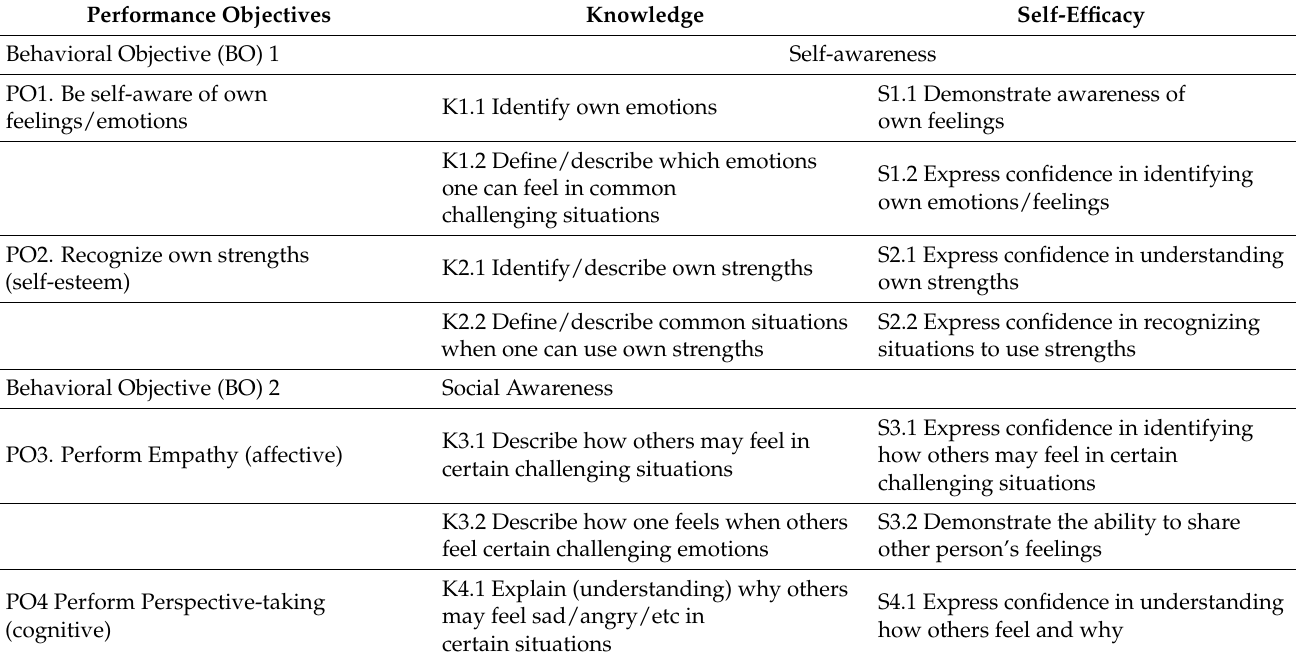
Table 2. Matrix of Change Objectives: Self-awareness & Social Awareness.